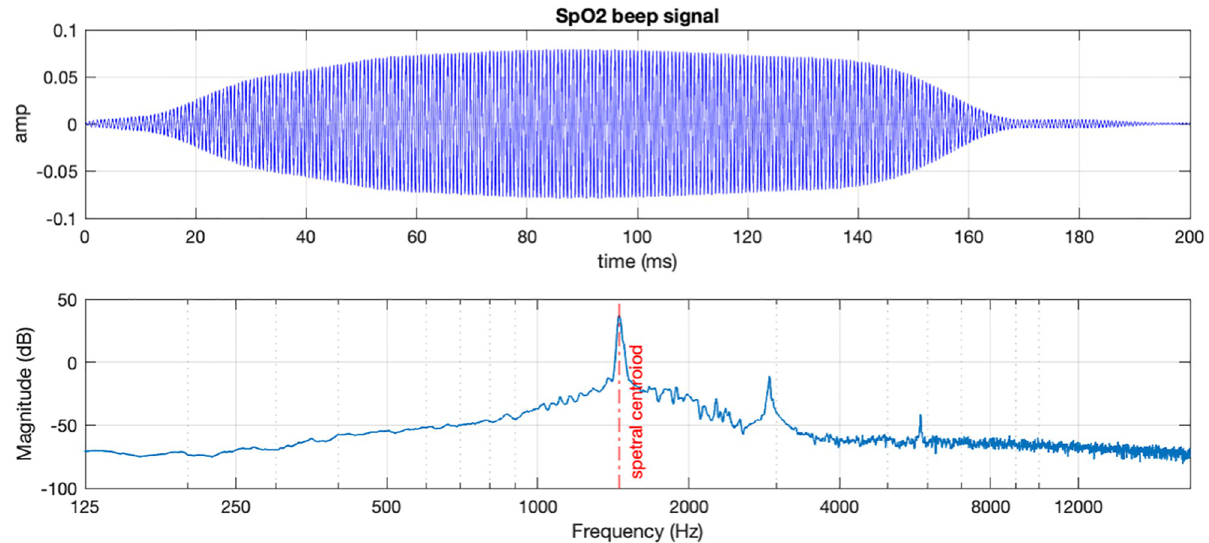
Fig 4. SpO2 generic beep recorded signal representation in time domain (top) and frequency domain (bottom). The 44100 Hz sample rate recording was done by one of the authors using a handheld recorder. The signal shows a fundamental at 1455 Hz, and two additional harmonic components of lower energy. Also visible are the longer rise and fall times than those of the priority